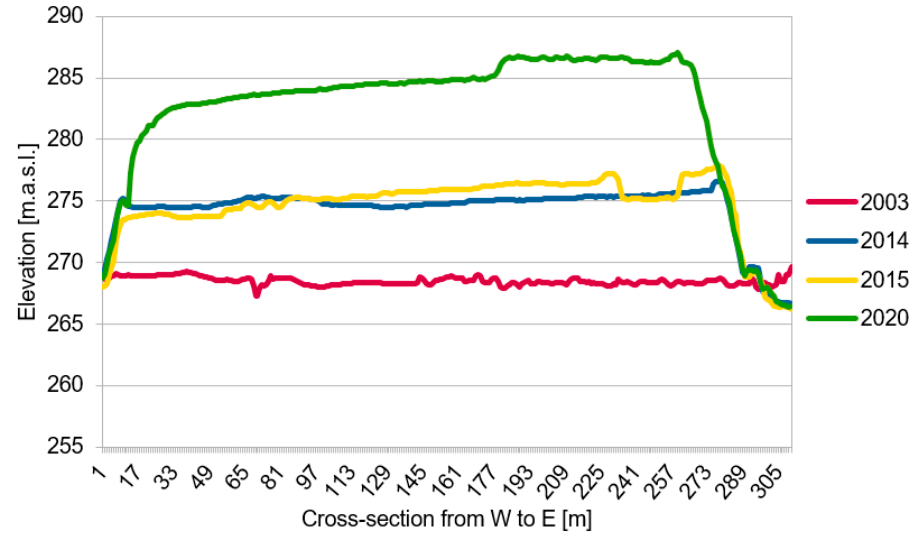
Figure 3. Cross ‐ section N–S with the profiles of dump canopy in period 2003–2020.